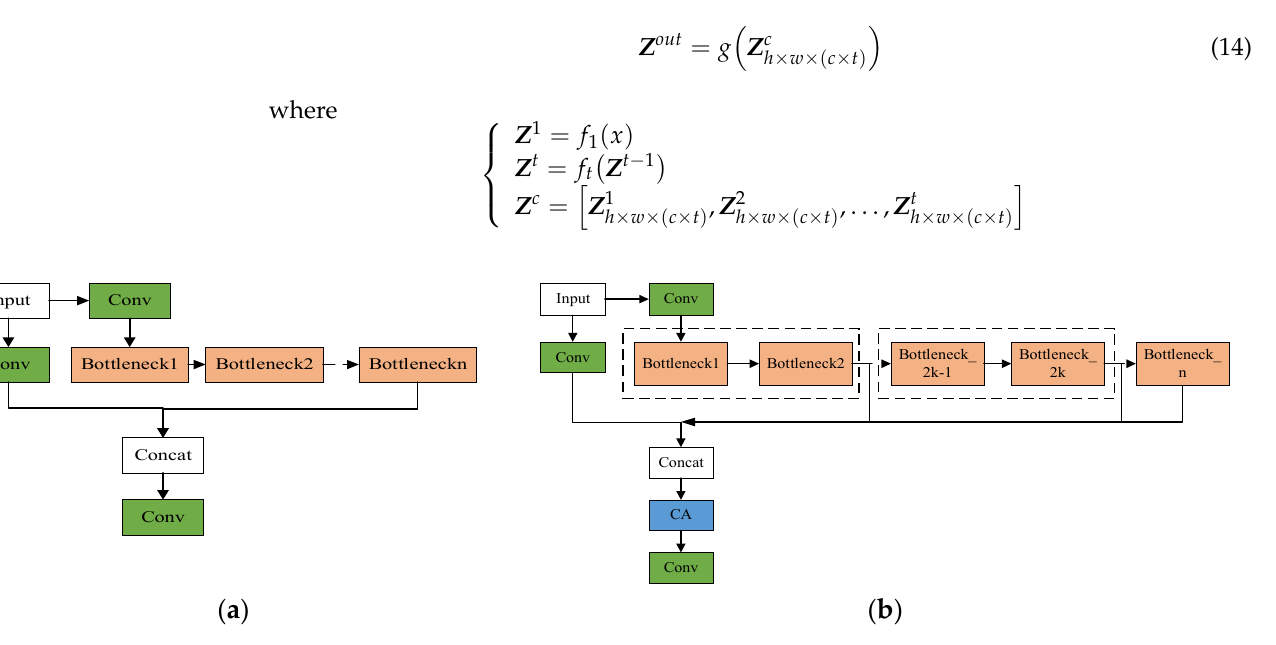
Figure 5. Comparison of BottleneckCSP before and after improvement. ( a ) BottleneckCSP module. ( b ) HDBottleneckCSP module.